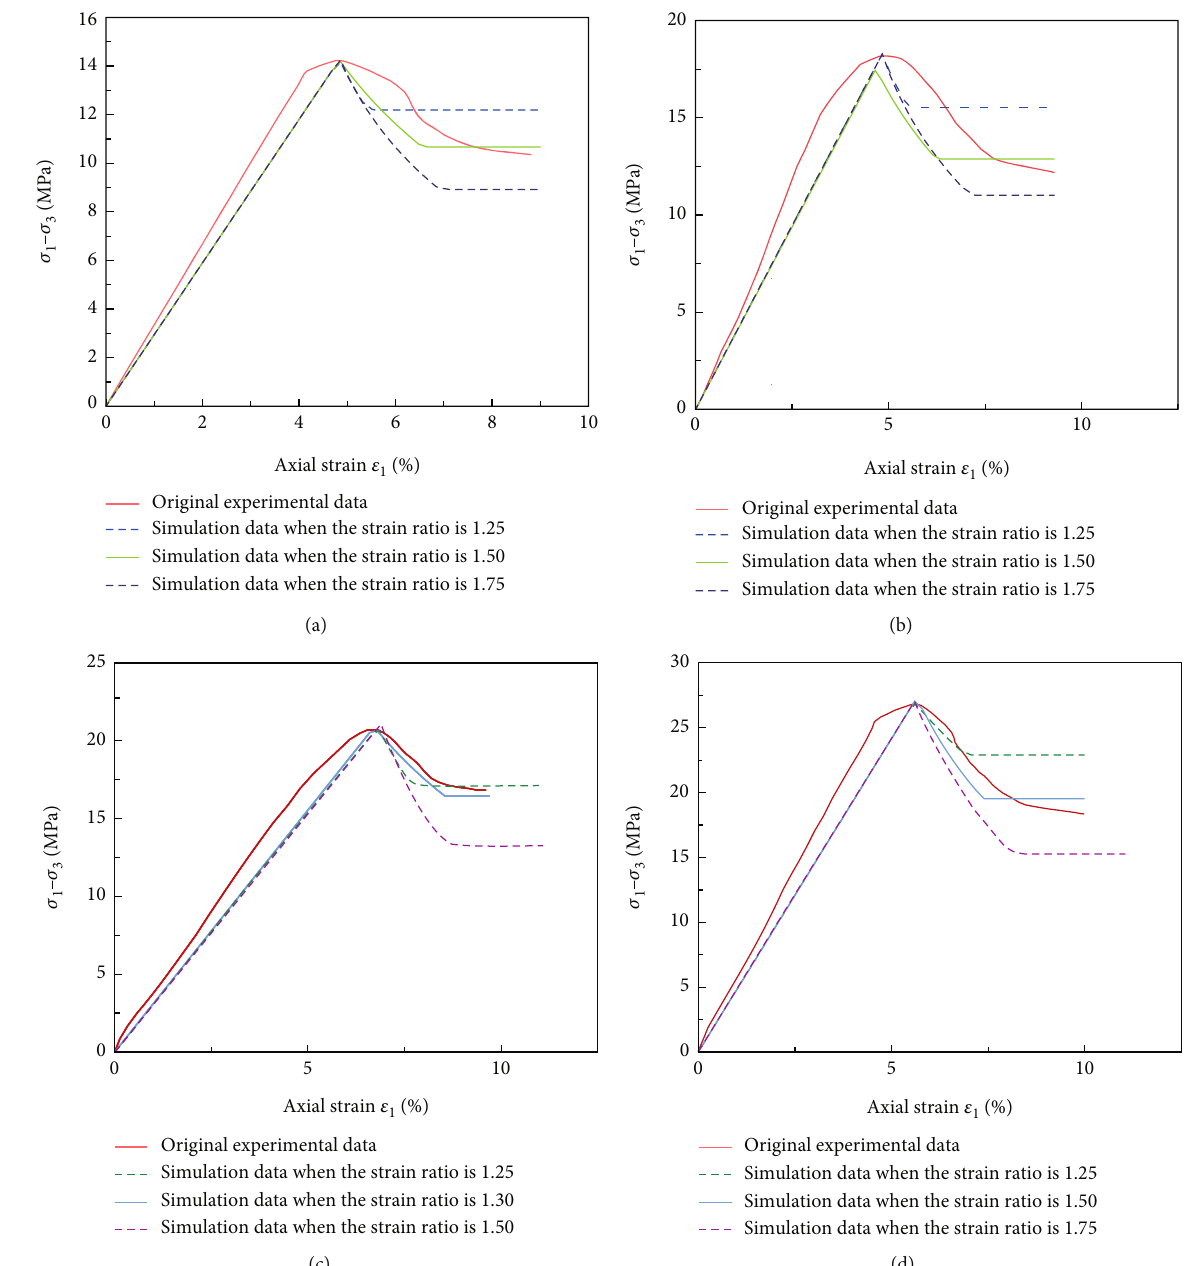
Figure 15: Error analysis of simulation results of briquette composed of soft coal at di ff erent equivalent residual strain ratios under di ff erent con fi ning pressures: (a) 2MPa, (b) 3MPa, (c) 4 MPa, and (d)